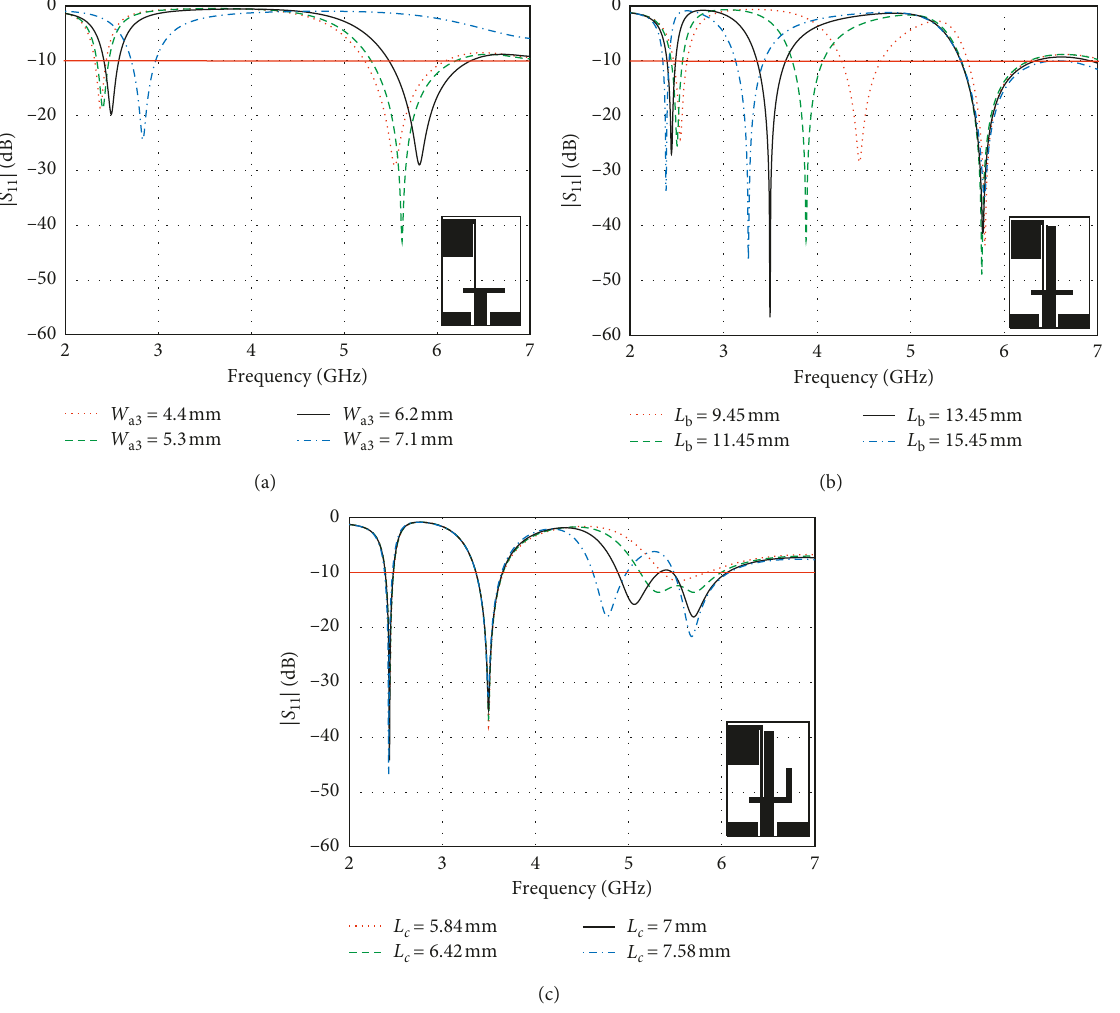
Figure 4: Simulated | S | at various stages of antenna evolution: (a) Antenna1, (b) Antenna2, and (c) 11